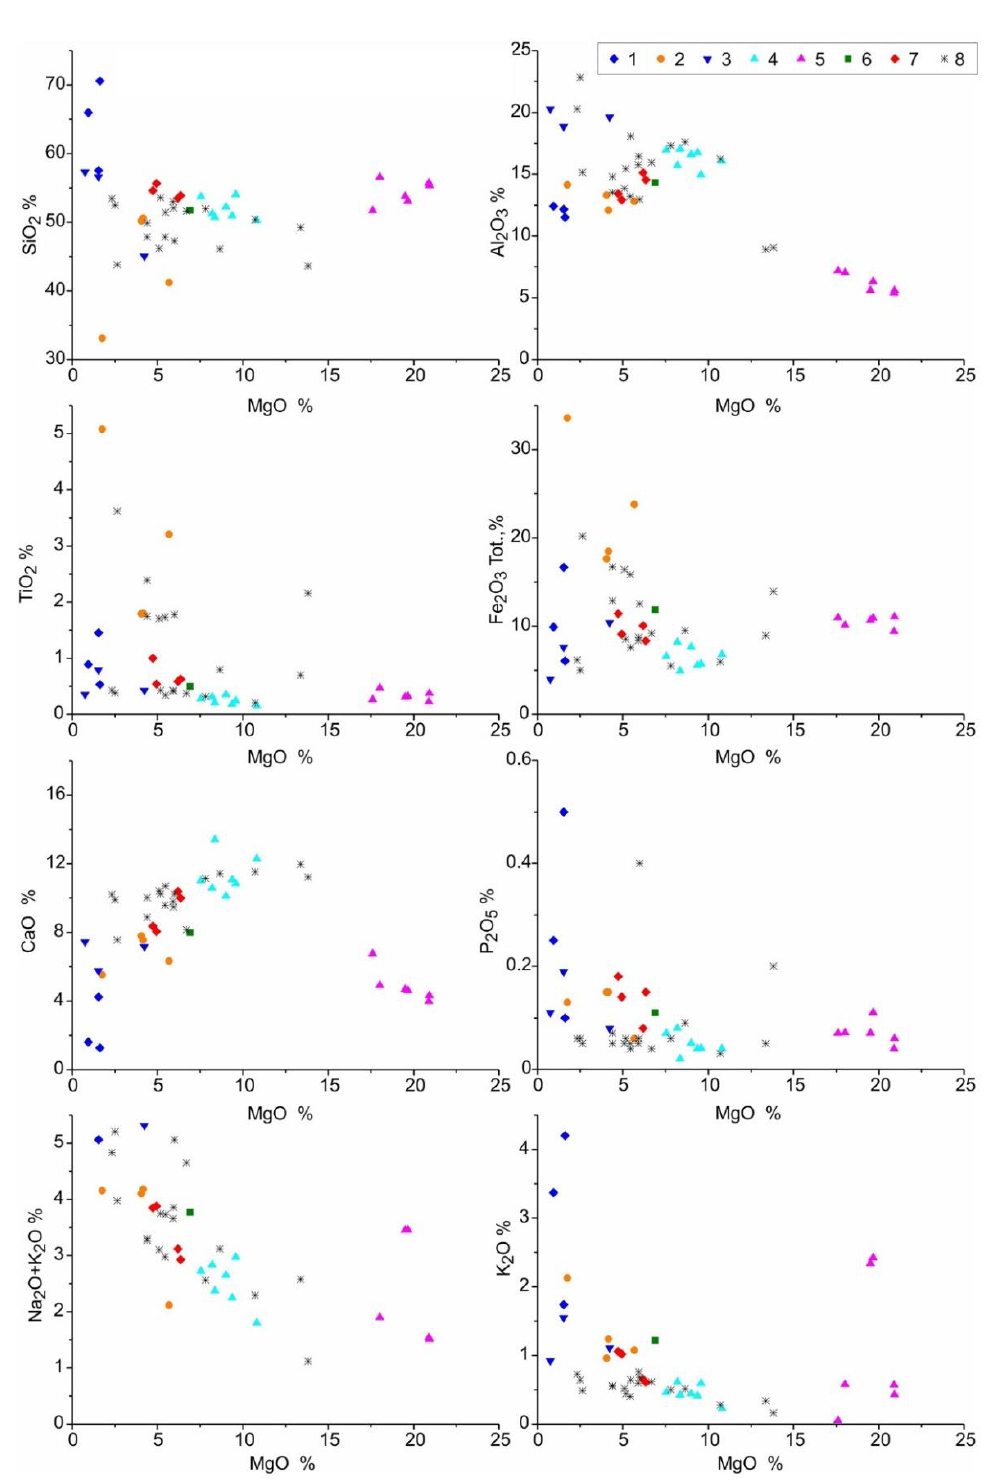
Figure 14. Petrochemical diagrams of MgO oxides in rocks of the Imandra–Umbarechka Complex and massifs of Ospe and Luvtuaivench. 1: Granophyrs; 2: Upper Border Zone; 3: Upper Layered Zone; 4: Main Layered Zone; 5: Lower Layered Zone; 6: Lower Border Zone of the Imandra–Umbarechka Complex; 7: rocks of the massifs of Ostrovsky; 8: Ospe and Luvtuaivench (data by